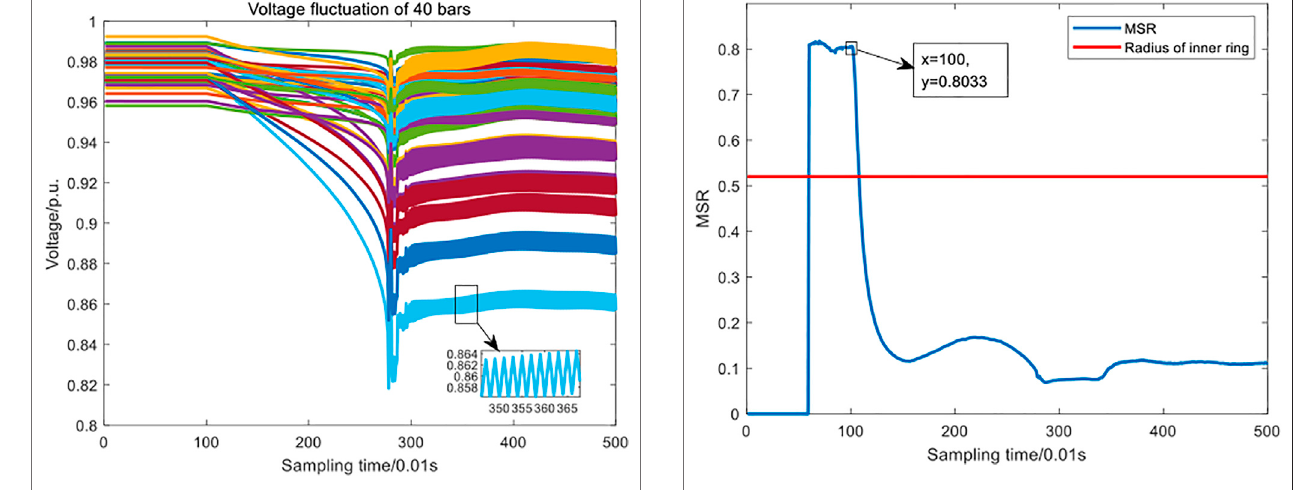
FIGURE 6 | Original voltage data of 40 buses in case 2.